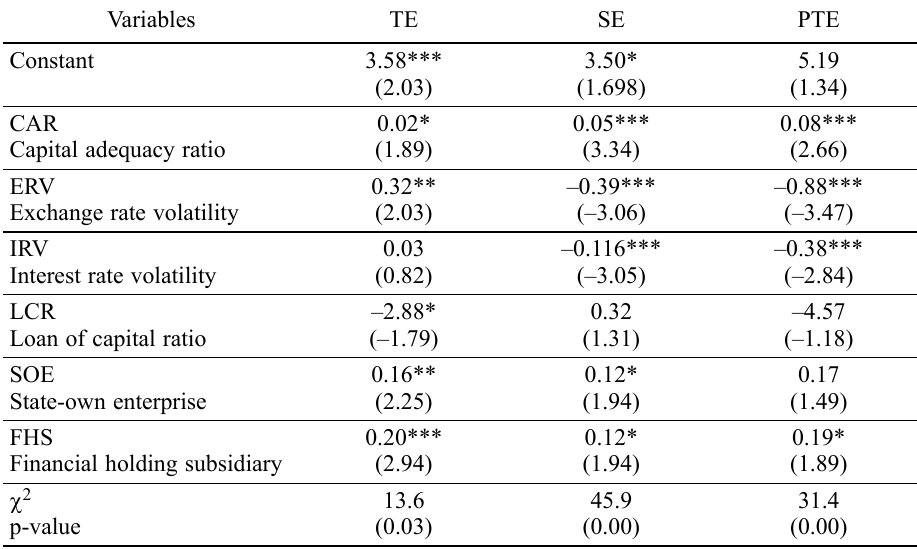
Table 5. Tobit regression: the relationship between risk factors and DMU